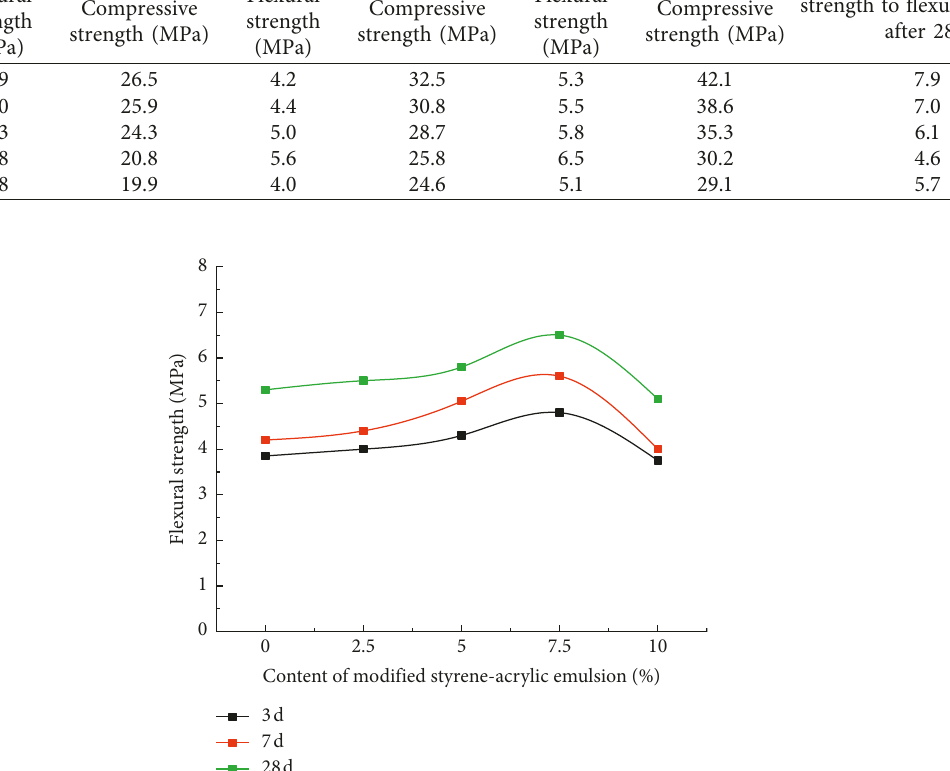
Table 5: Influence of the modified styrene-acrylic emulsion on the flexural and compressive strengths of solidified cement slurry. Polymer content